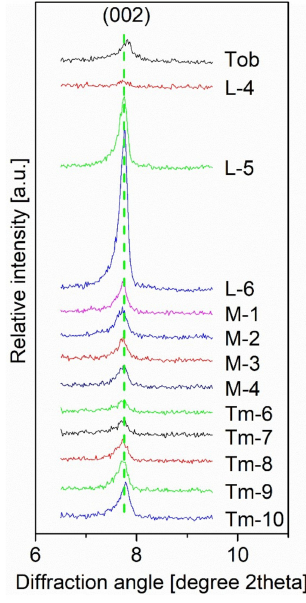
Figure 3. Enlargement of the diffraction peak of tobermorite (002). The sample (Tob) without Al was synthesized with a 0.83 Ca/Si molar ratio under the same temperature, time and water/solid ratio to those of M–1 to M–9, and Ca and Si sources were from lime and fumed silica powder, respectively. Data of Tm–6 to Tm–10 were from the previous publication